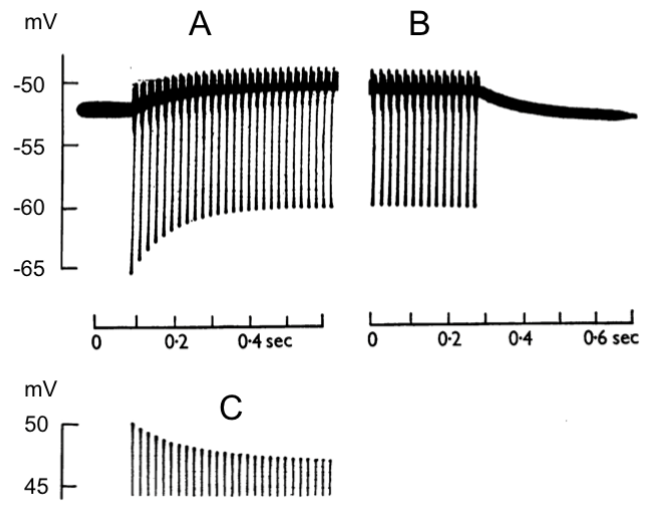
Figure 1. Recording of a train of action potentials evoked at 50 Hz, which result in ( A ) a decrease in the peak amplitude of later action potentials, ( B ) development of a depolarisation of the membrane potential and a decrease in the AHP amplitude. ( C ) On cessation of the stimulus, the membrane potential returns to rest (adapted from Ref. [18]).